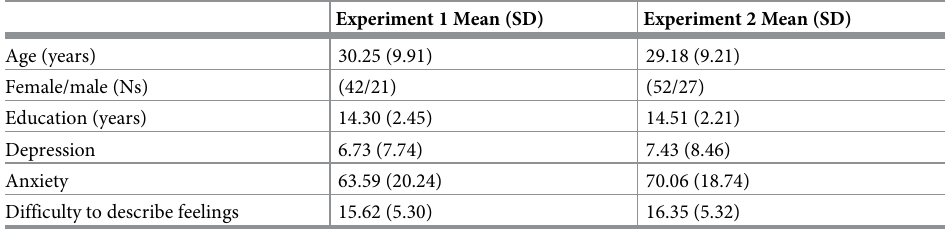
Table 1. Demographic characteristics of individuals who participated in Experiments 1 and 2 (means and stan- dard